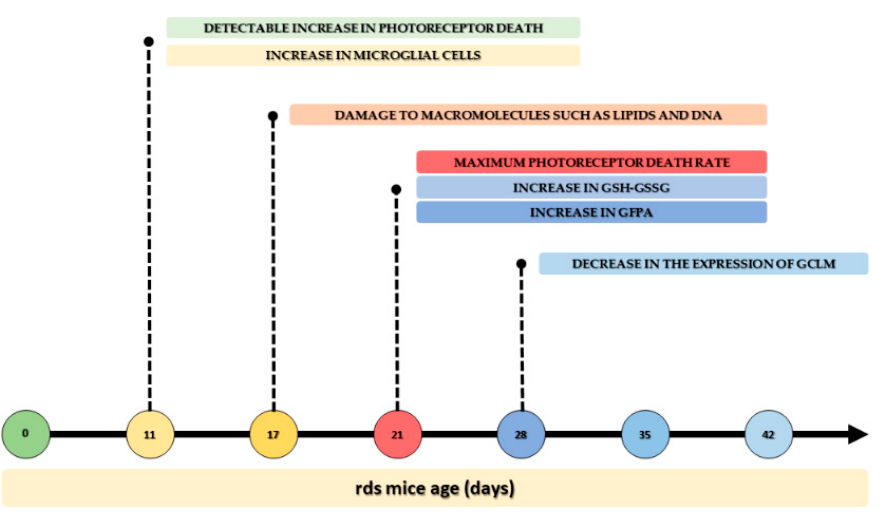
Figure 12. Time sequence of changes in oxidative stress and inflammation in the rds animal model of RP.